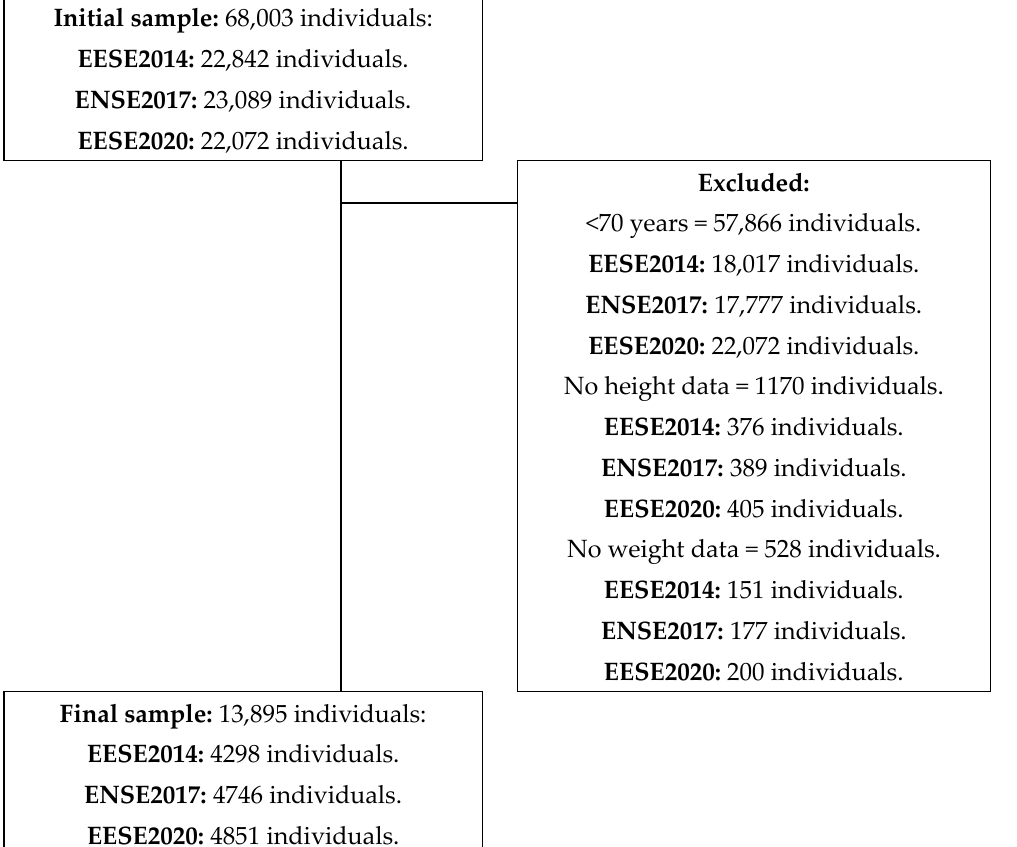
Figure 1. Flowchart outlining the study sample’s eligibility criteria.